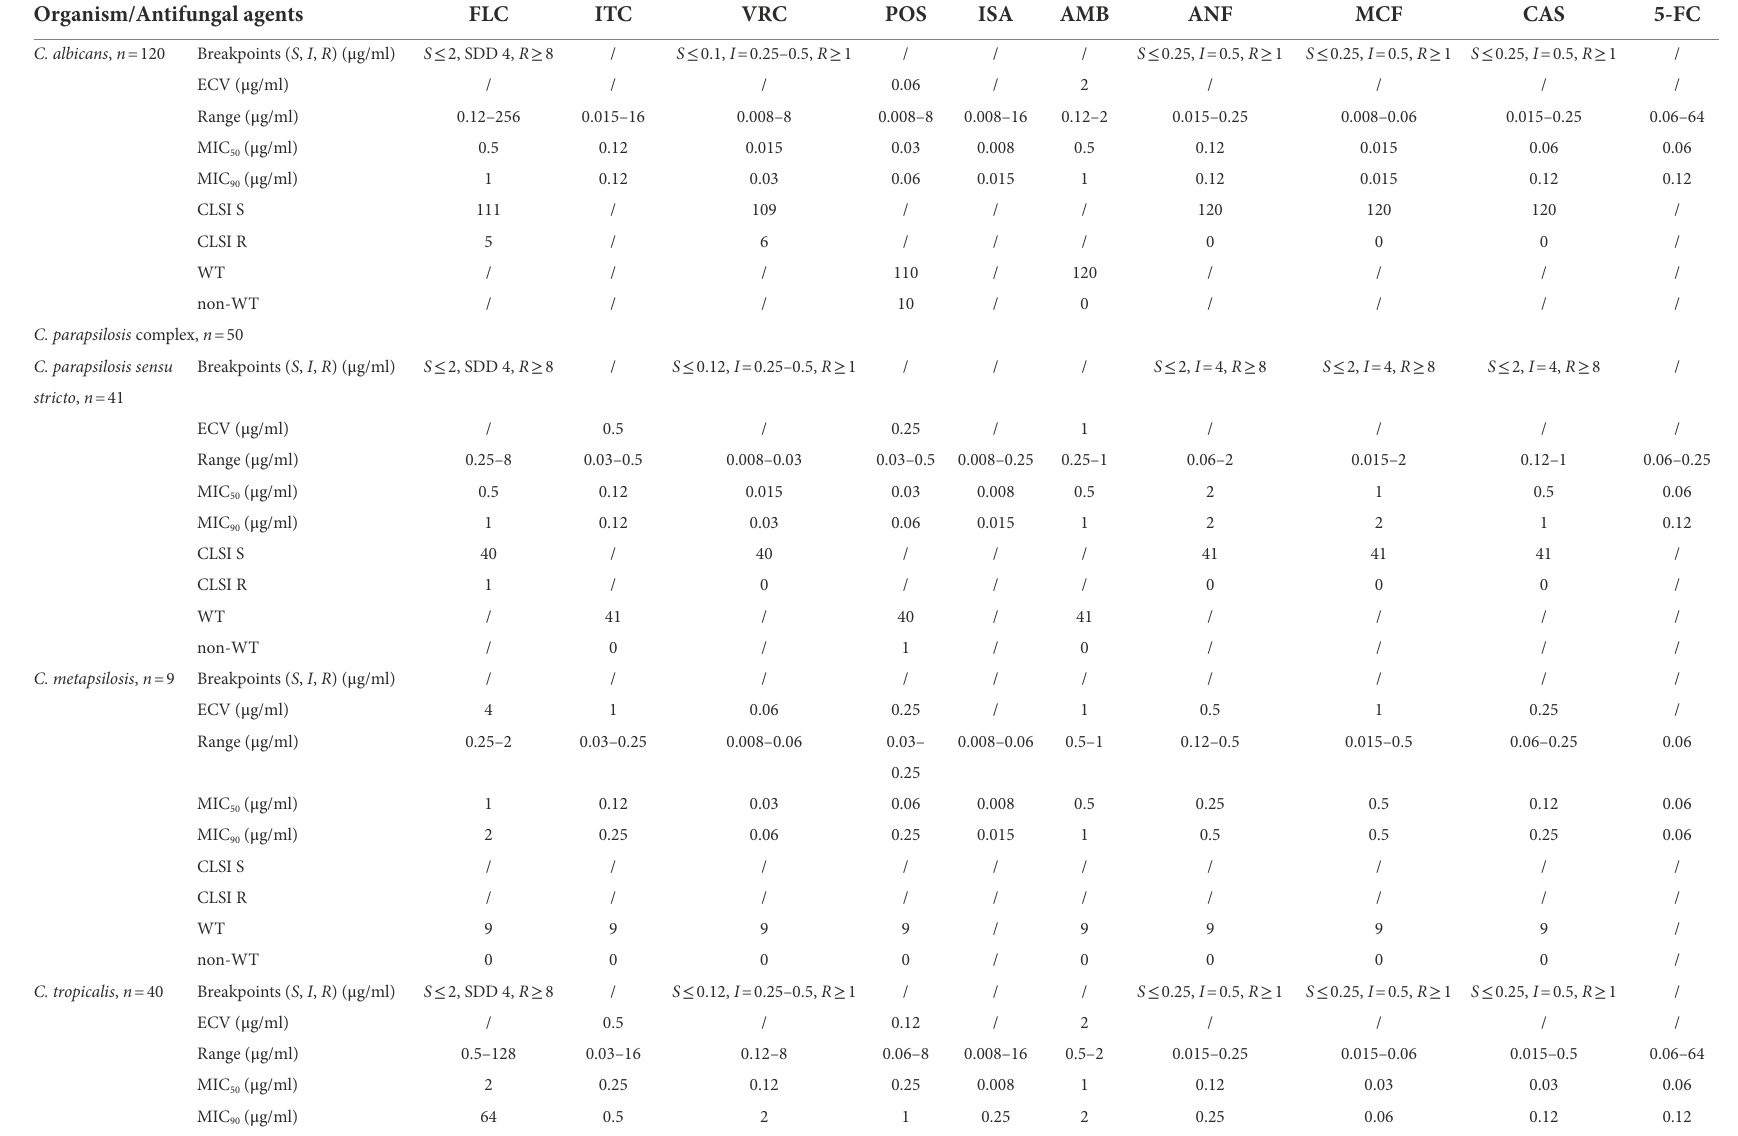
TABLE 2 Activities of 9 antifungal drugs against yeast species according to CLSI clinical breakpoints or